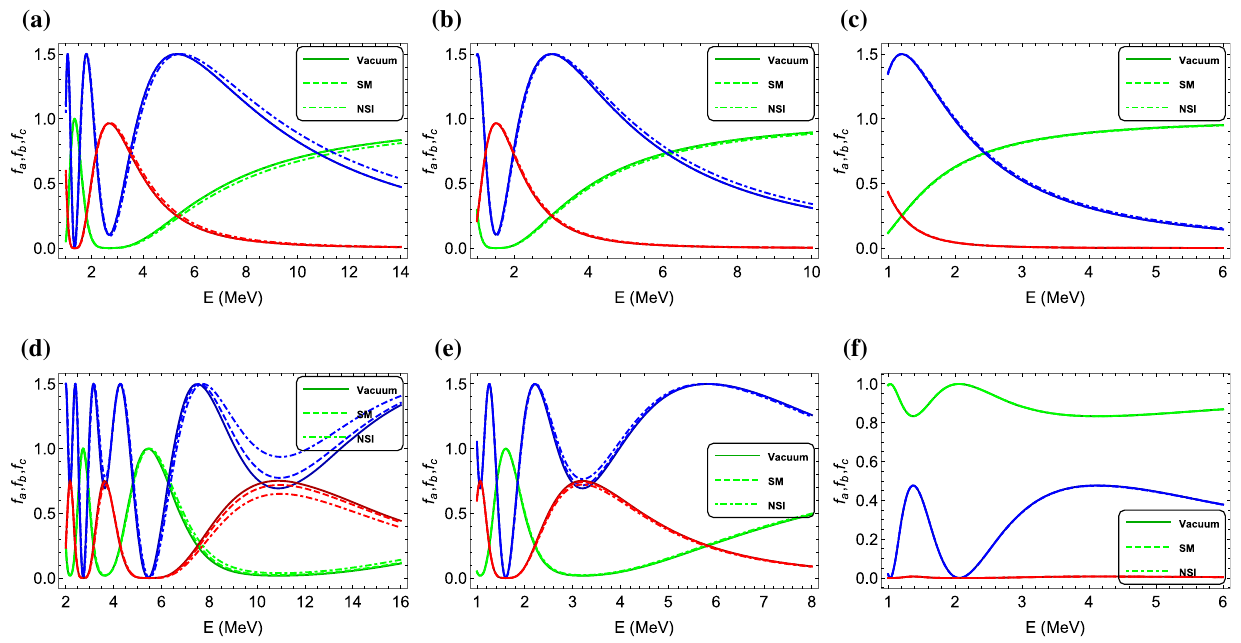
lower middle: JUNO, L = 53 km, E ≈ 1 − 8 MeV; f lower right: Daya Bay, L = 2 km, E ≈ 0 . 8 − 6 MeV. The solid, dashed and dot-dashed curves correspond to neutrino oscillations under vacuum, SM and NSI scenarios,